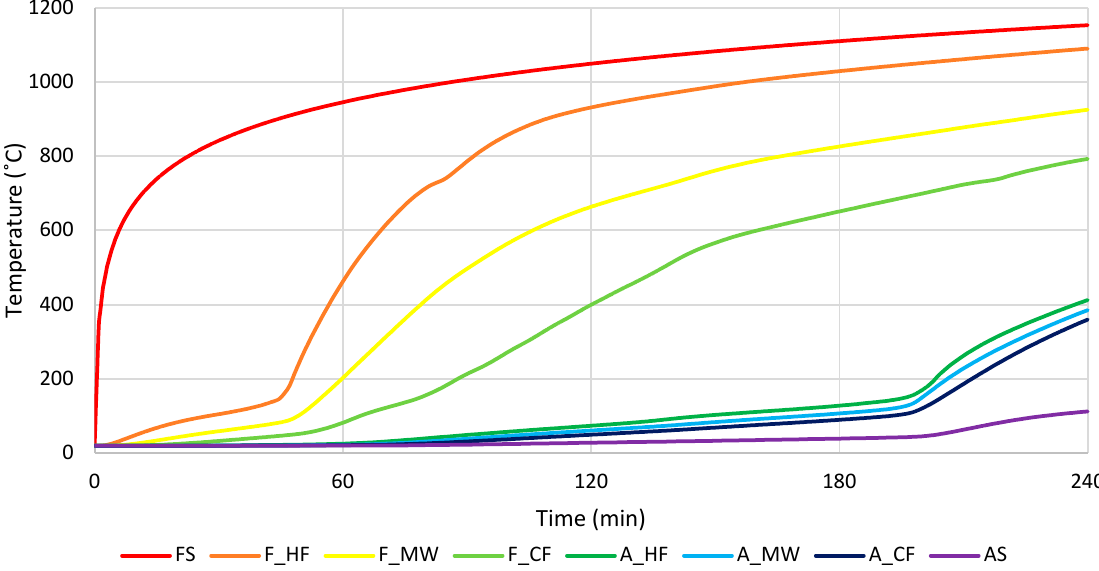
Figure 9. Time variant temperature through floor thickness of M_DP_120RW floor system. The locations through floor thickness can be referred to as presented in Figure 10.